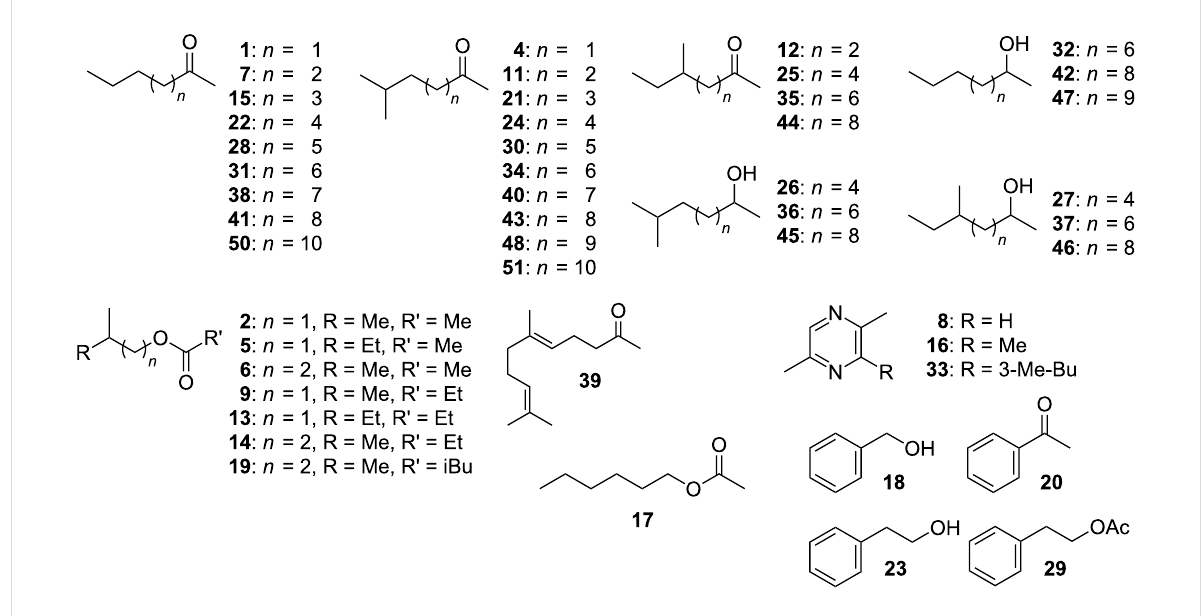
Figure 3: Structures of compounds emitted by Xanthomonas campestris pv. vesicatoria 85-10. Compound labels are the same throughout this paper.